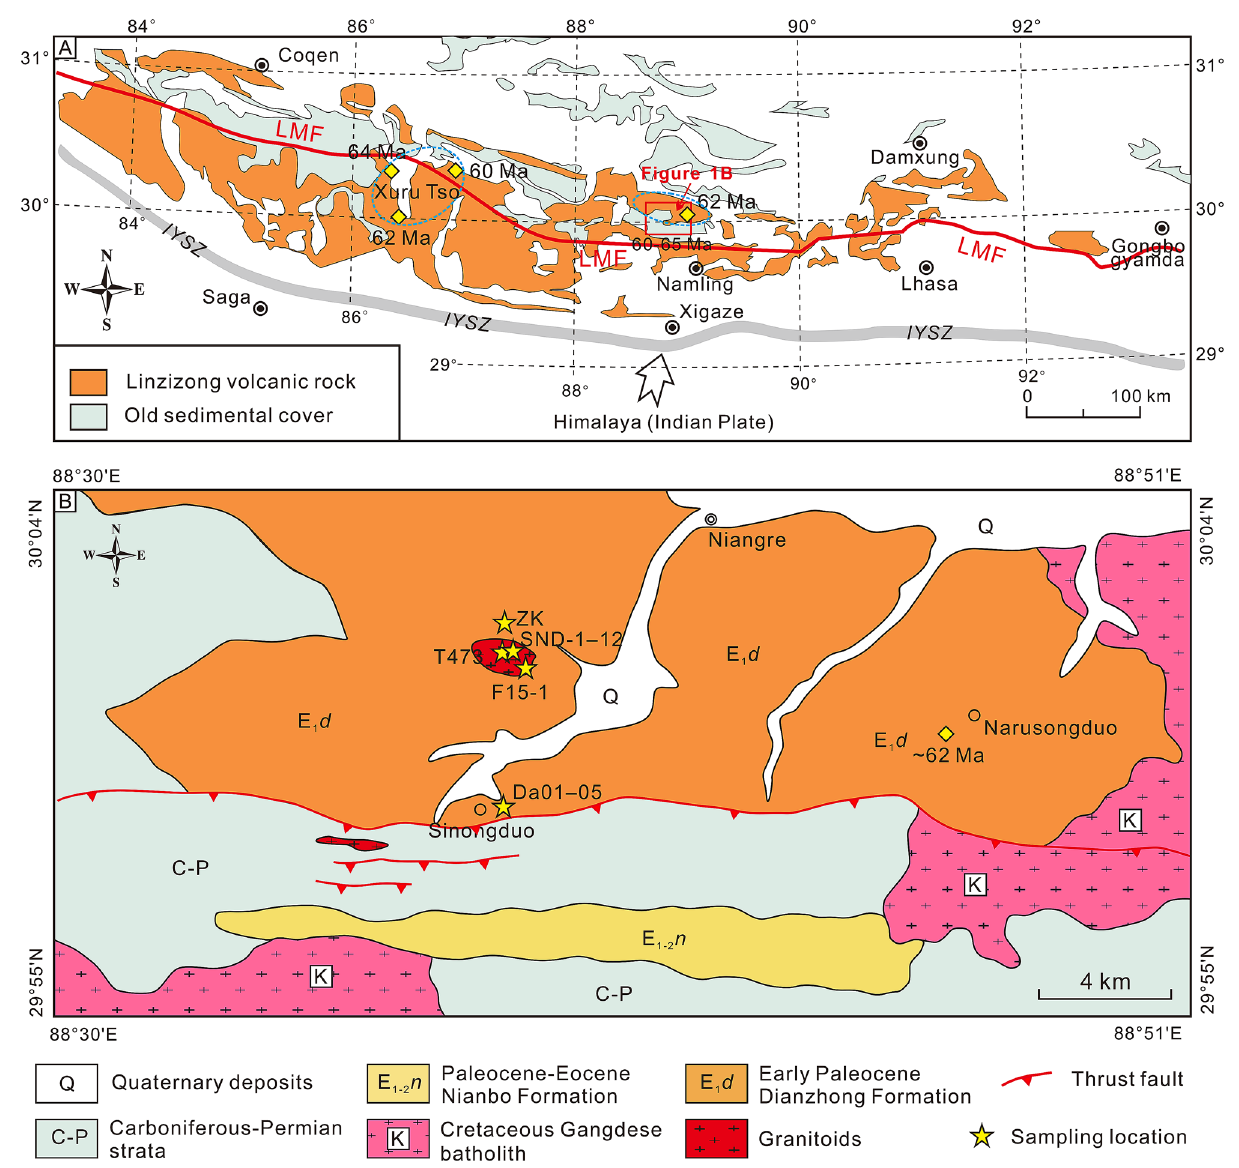
Figure 2. ( A ) Simplified tectonic framework of the southern margin of the Lhasa block showing the location of the study area. ( B ) Regional geological map showing the study area, modified from the China Geological Survey (www. cgs. gov. cn) based on our field observations. The maps were generated by Zongyao Yang, using CorelDRAW X8 version 18.0.0.448. Yellow diamonds represent literature data of Paleocene S-type magma 9–12 . Blue dashed circles represent the approximate extent of the s-type granitic rocks. LMF Luobadui–Milashan wt%) contents compared with the normal Dianzhong magmatic rocks 5,6,8,9 . The volcanic rocks and granitoids plot within the rhyolite and granite fields, respectively, on the total alkalis vs. silica (TAS) diagram (Fig. 5A). The alumina saturation index (ASI = mol. Al 2 O 3 /(CaO + Na 2 O + K 2 O)) values of these rocks are in the range of 1.64–2.10, indicating that they are strongly peraluminous (Fig. 5B) and similar to the S-type granites such as those from the Lachlan fold belt 23,24 (Fig. 5B). As shown in the chondrite-normalized rare earth element (REE) patterns (Fig. 5C), the Linzizong granitoids have enriched light REE (LREE) and relatively flat heavy REE (HREE) pat- terns with obvious negative Eu anomalies (Eu/Eu* = 0.56–0.82). Their primitive mantle-normalized incompatible trace element patterns (Fig. 5D) exhibit enrichment in some large ion lithophile elements (LILEs) (e.g., Rb, Th, U, and Pb) and depletions in Ba, Sr, and high field strength elements (HFSEs), particularly Nb, Ta, and Ti. The normalized REE and incompatible element abundance curves of the Linzizong granitoids are similar to those of the volcanic rocks from the Sinongduo area, indicating they formed from similar primary magma 21 . Whole- rock Sr–Nd–Pb isotope data for the Linzizong granitoids are listed in Supplementary Table S3. The granitoids have uniform 87 Sr/ 86 Sr ratios of 0.7247–0.7293 and 143 Nd/ 144 Nd ratios of 0.5122–0.5123, whereas the volcanic samples of rhyolite, tuff and dacite exhibit variable 87 Sr/ 86 Sr (0.7146–0.7531) but homogeneous 143 Nd/ 144 Nd